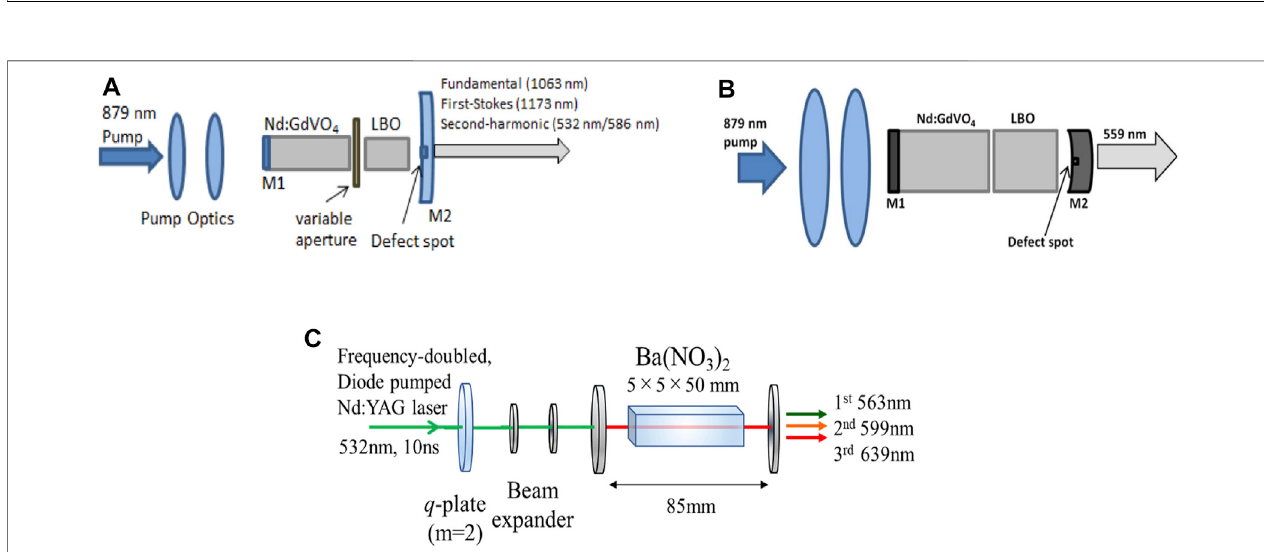
FIGURE8|(A) SHGofNd:GdVO 4 self-Ramanfor532/586 nmvortexoutput[125] (B) SFGofNd:GdVO 4 self-Ramanfor559 nmvortexoutput[126] (C) cascaded Ba(NO 3 ) 2 Raman for 563/599/639 nm vortex output with extra-cavity con fi guration